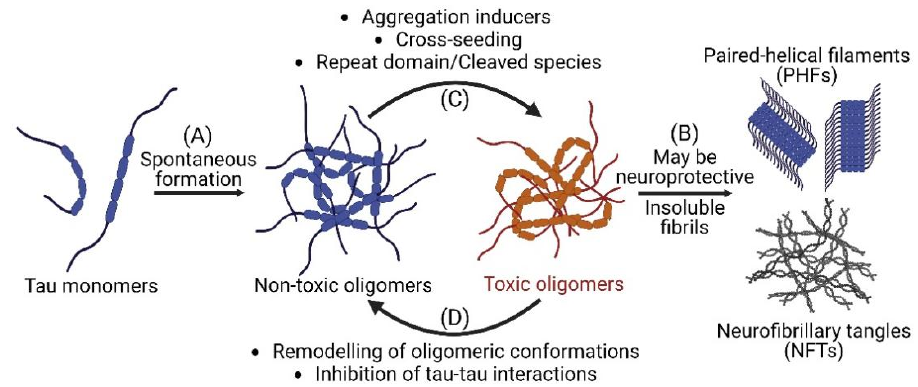
Figure 1. Tau oligomerization and fibrillization in Alzheimer’s disease and related tauopathies. ( A ) Misfolded tau monomers spontaneously form into both non-toxic and toxic soluble tau oligomers which subsequently fibrillize into insoluble paired helical filaments (PHFs) and neurofibrillary tangles (NFTs). ( B ) Insoluble species have been proposed to potentially have neuroprotective effect by sequestering toxic oligomers. ( C ) Aggregation inducers, cross-seeding, and the presence of tau repeat domain or cleaved species can facilitate the transition from non-toxic to toxic oligomers. ( D ) Small molecules that remodel tau oligomeric conformations or inhibit tau-tau interactions can promote the conversion of toxic to non-toxic oligomers and reduce neurotoxicity. Schematics are created with BioRender.com accessed on 10 October 2022.